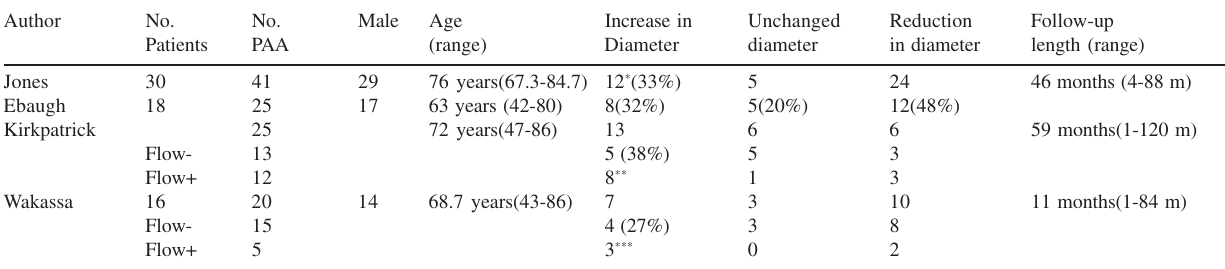
Table 3 - Comparison of patients that underwent ligation and exclusion of the aneurysmal sac